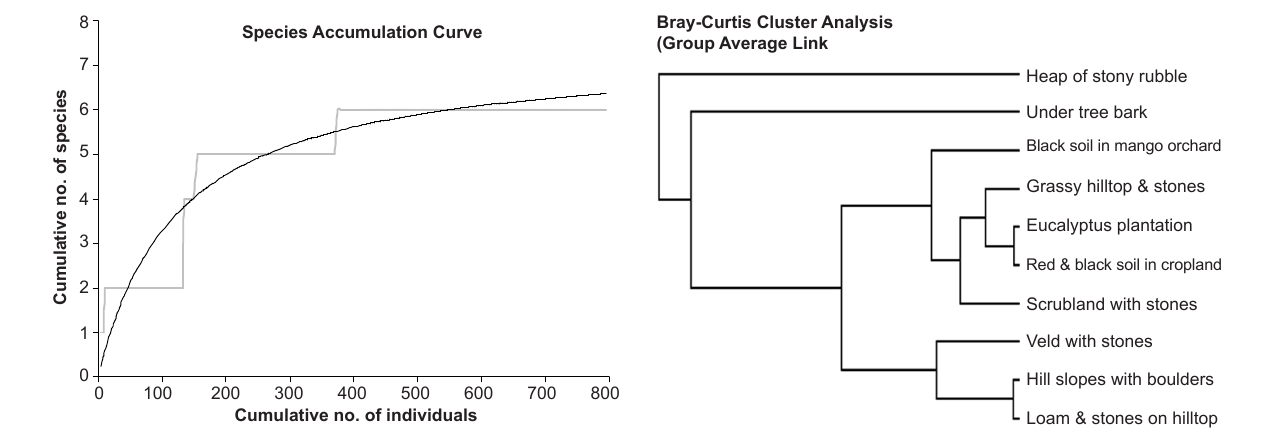
Figure 2. Species Accumulation Curve of Scorpions of study area. Least square curve had the parameters S 124.5, predicting the maximum number of species inhabiting the study area to be 8. Though we could record only 6 species in Quadrates, two more were found out of the Quadrates but in the study area. Black solid line indicates theoretical curve (using Michelis-Menton equation) and Grey line represents the actual quadrate data.